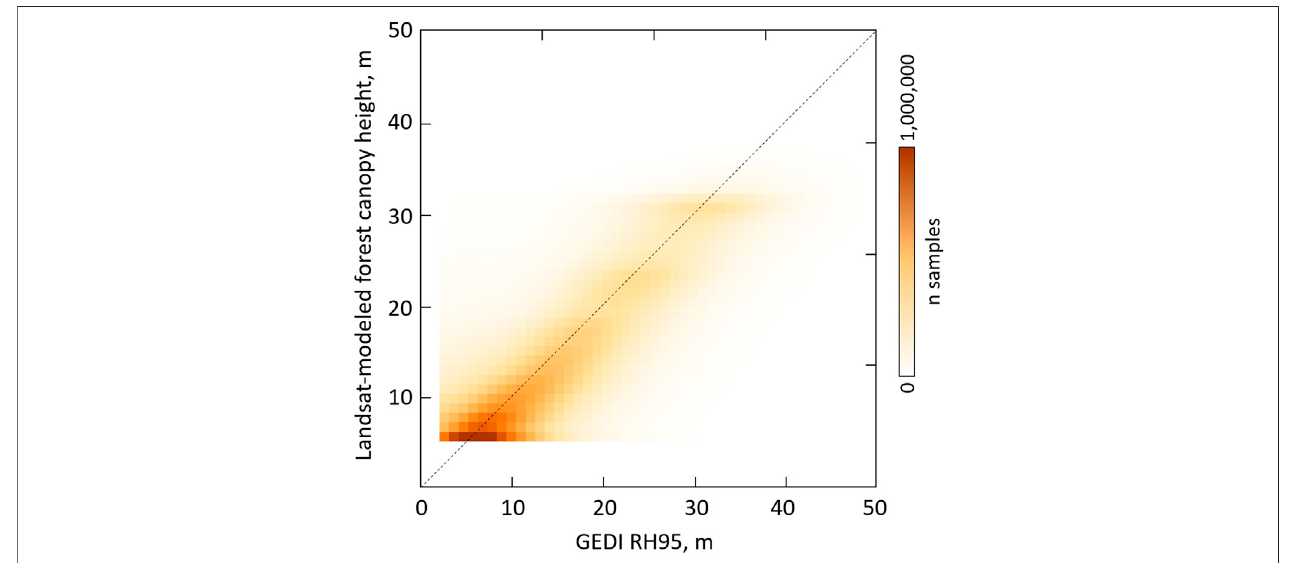
FIGURE 8 | Comparison of the Landsat-based year 2020 forest height map values with the GEDI Collection 2 data within stable forests. The analysis is performed within the GEDI data range. N = 104,673,802.